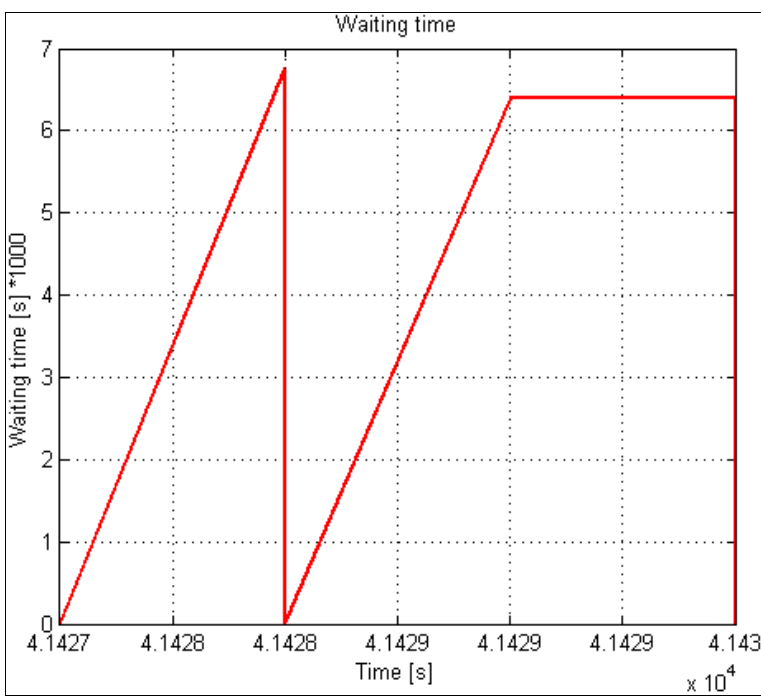
Figure 22. The queue changes depending on the number of waiting users.